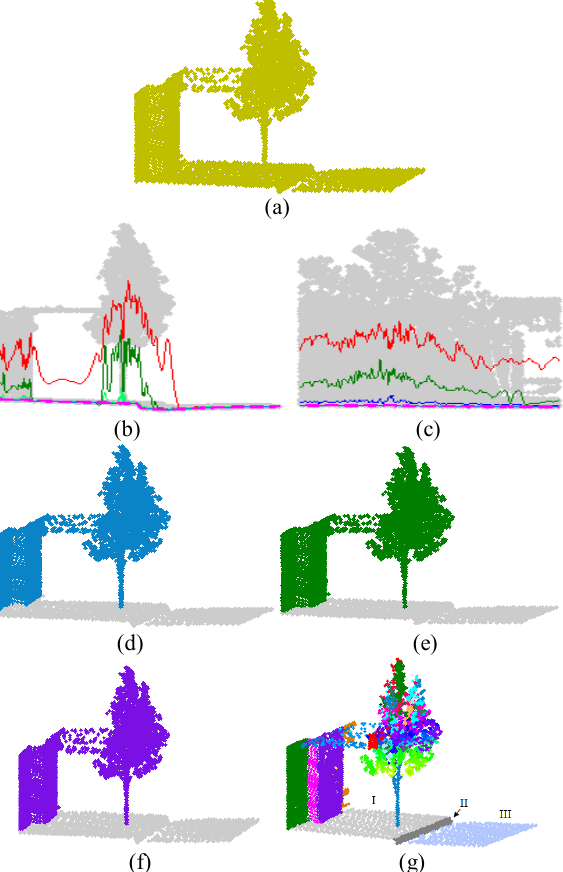
Figure 4. (a) Dataset 1, (b) RLWR fits in X-Z profile (c) RLWR